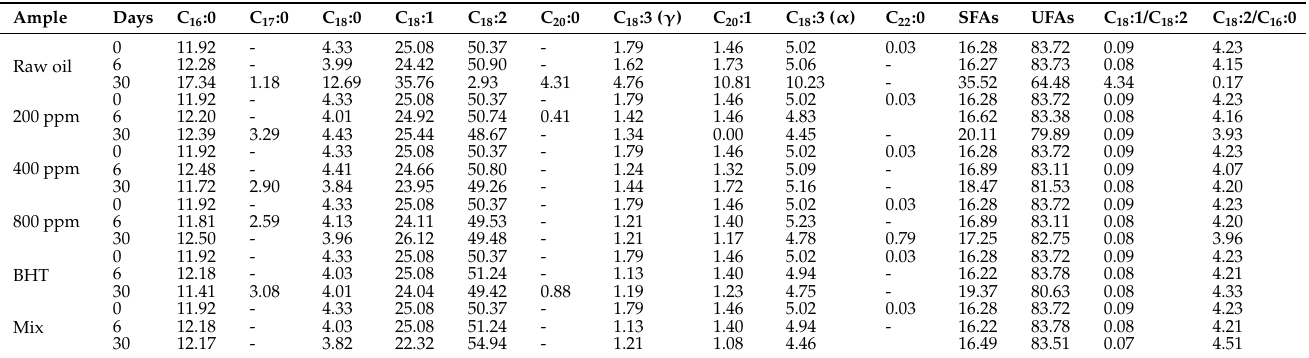
Table 4. Fatty acids composition (%) of soybean enriched with PGG extract, BHT, and PGG/BHT during accelerated storage for 30 days at 65 ◦